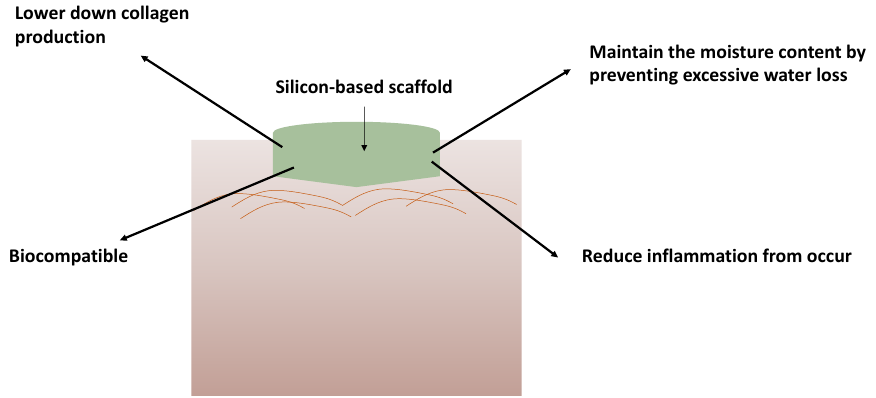
Figure 6. Application and the benefits of silicon-based scaffold on wounds for wound healing treat- ment.